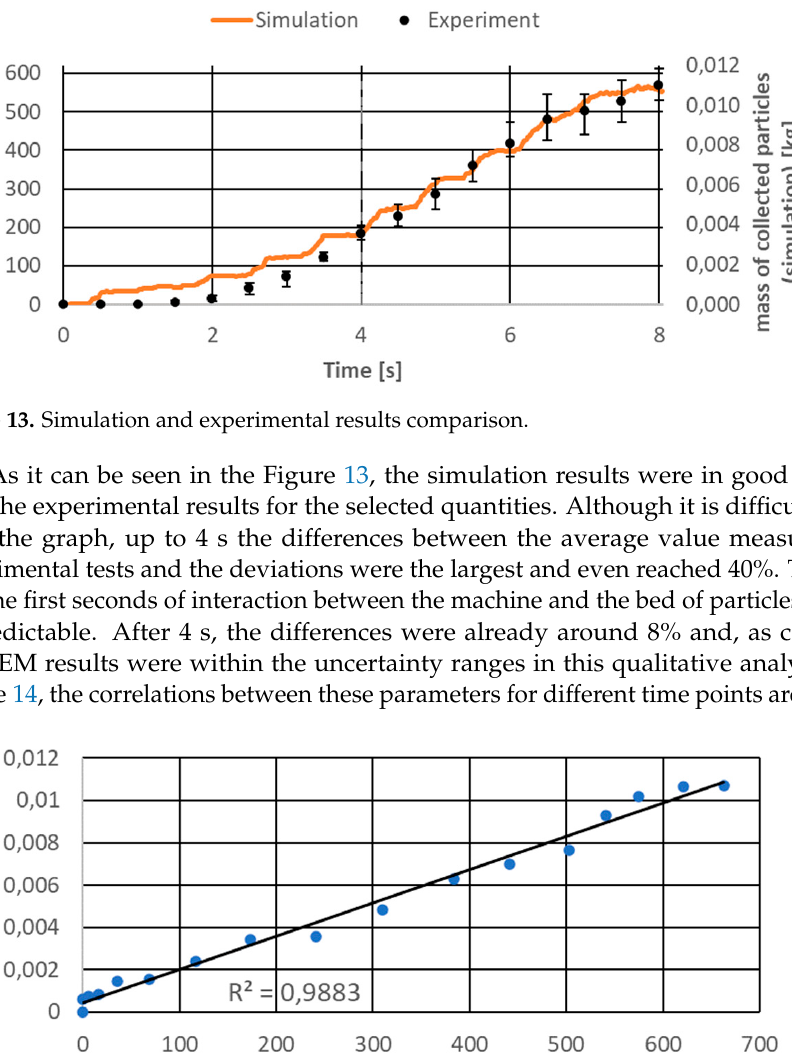
Table 1. Gravitational conditions used in DEM